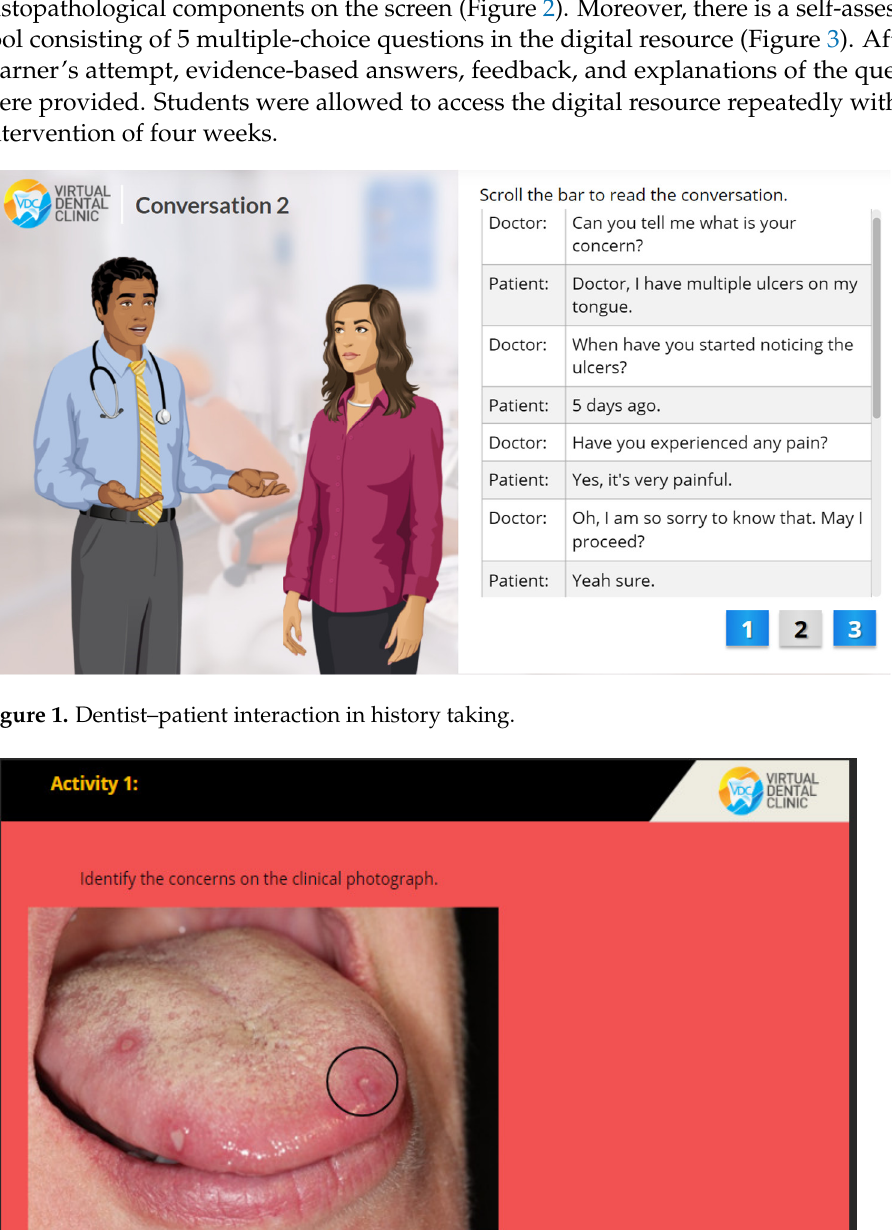
Figure 3. Self-assessment tool. 2.4. Virtual Role Play Activity Five virtual role play sessions involving the same case scenarios were scheduled for the control group within a time frame of four weeks. During each session, the patient’s script was provided to the facilitator (faculty) who enacted as the patient while one of the students in the control groups enacted as a clinician. After students completed the history taking, the clinical images of oral lesions were provided to the students. After the student mentioned the investigations, the findings of the investigation were provided to them. At the end of role playing, students presented complete history, provisional diagnosis, differential diagnosis, investigations, and management of the given case to the facilitator. 2.5. Learning Evaluation The effect of interventions was evaluated by conducting a virtual objective structured clinical examination (OSCE). There were five OSCE cases aligned to the same learning outcomes. Students in both groups were assessed in two phases: before the intervention (pre-test), and after the intervention (post-test). The examiner acted as the simulated patient. The clinical images, radiographic images, or investigation results were provided